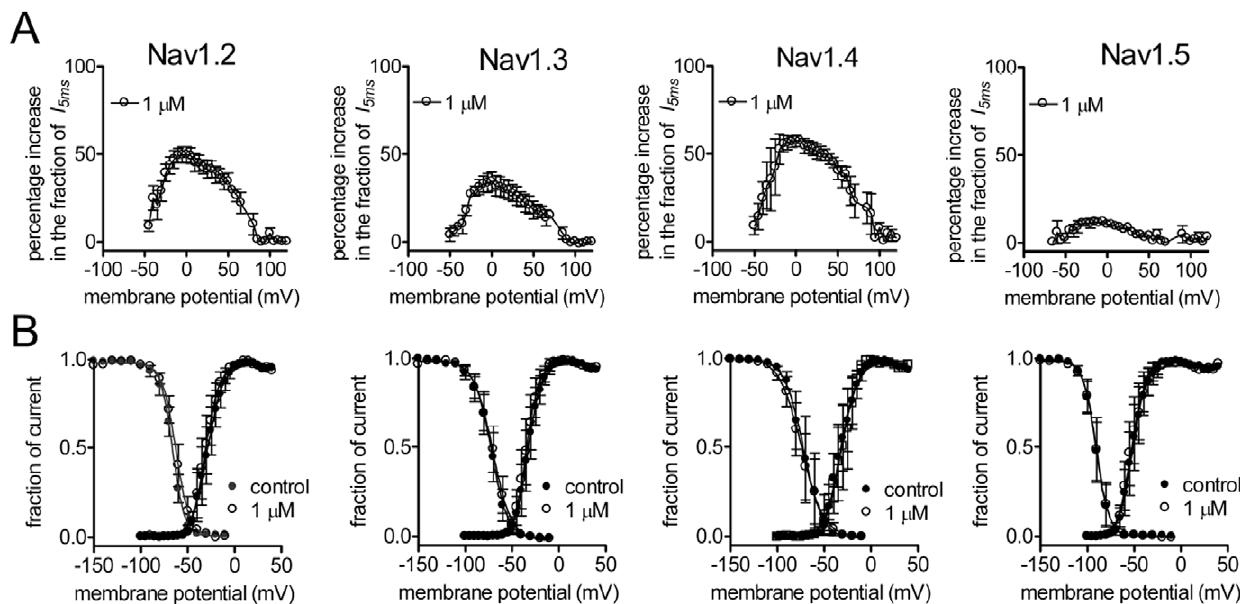
Figure 8. Effects of CvIV4 on activation and inactivation of Na v 1.2, Na v 1.3, Na v 1.4 and Na v 1.5. 50-ms depolarizing pulses were used to elicit Na + current from channel isoforms expressed in HEK cells before and after the application of 1 m M CvIV4. Cells were held at 2 100 mV. Depolarizing potentials ranged from 2 100 to + 120 mV in 5-mV increments. A. Currents not inactivated at 5 ms in the presence of 1 m M toxin were plotted as the percentage increase in the fraction of current at 5 ms ( I 5 ms ). B. Effects of CvIV4 on steady-state activation and inactivation of Na +